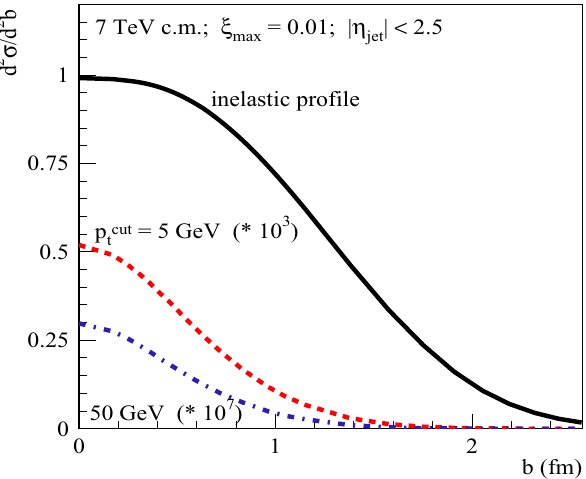
Fig. 10 Left: ξ max -dependence of the calculated SD dijet cross sections: σ 2jet ξ max -dependence of the corresponding RGS probabilities: S | η | < 2 . 5 jet